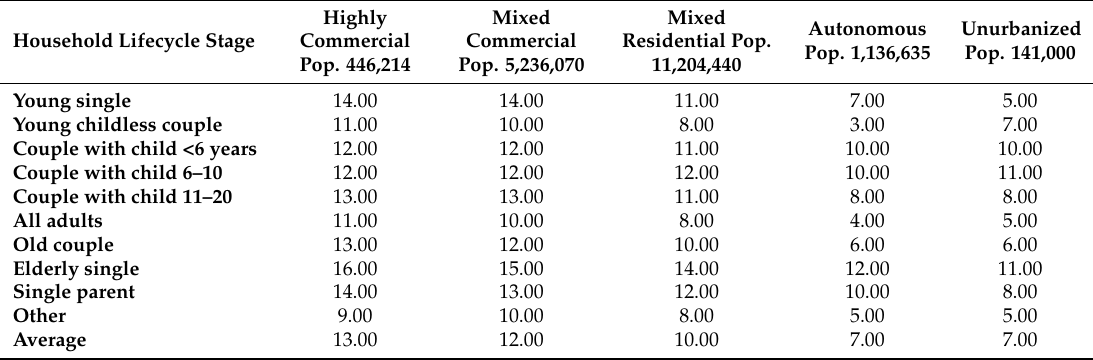
Table 6. Reduction in the risk of mortality to the population shown by built environment and lifecycle stage.